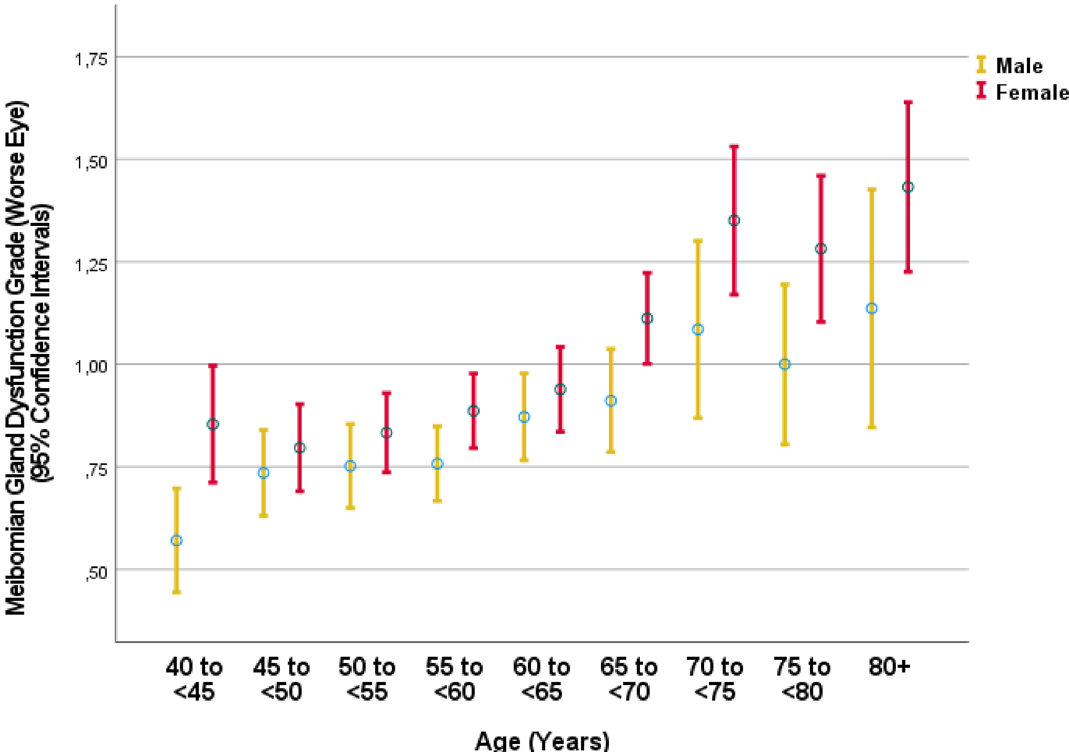
Figure 3. Graph showing the distribution of Meibomian gland dysfunction stratified by age and sex in the Ural Eye and Medical Study.